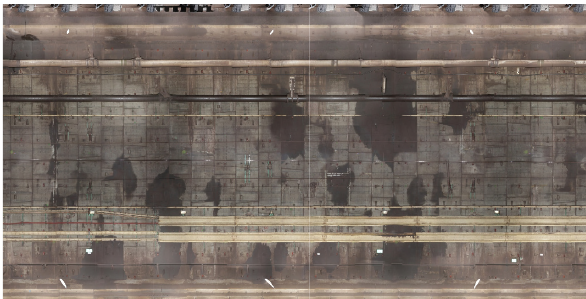
Figure 15. Orthophotography of Tunnel (cylindrical projection)